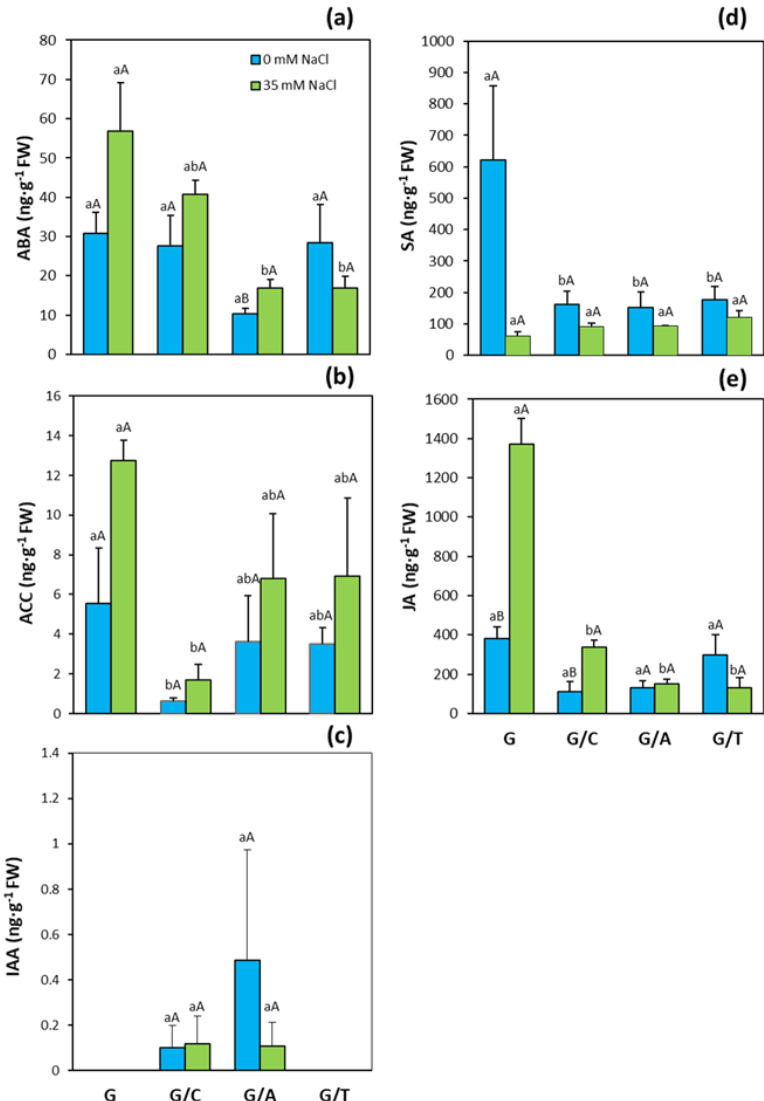
Figure 6. ( a ) Abscisic acid (ABA), ( b ) 1-aminocyclopropane-1-carboxylic acid (ACC), ( c ) indole acetic acid (IAA), ( d ) salicylic acid (SA), and ( e ) jasmonic acid (JA) concentrations in leaves of pepper plants of the commercial variety “Gacela F1” either non-grafted (G) or grafted onto the commercial rootstocks Creonte (G/C), Atlante (G/A), and Terrano (T/A), and cultivated under control (0 mM NaCl) and salinity (35 mM NaCl) conditions. Bars show the means of five plants ± standard error. Different capital letters indicate significant differences due to the salt treatment while different small letters show significant differences among graft combinations according to Tukey’s test ( p ≤ 0.05).